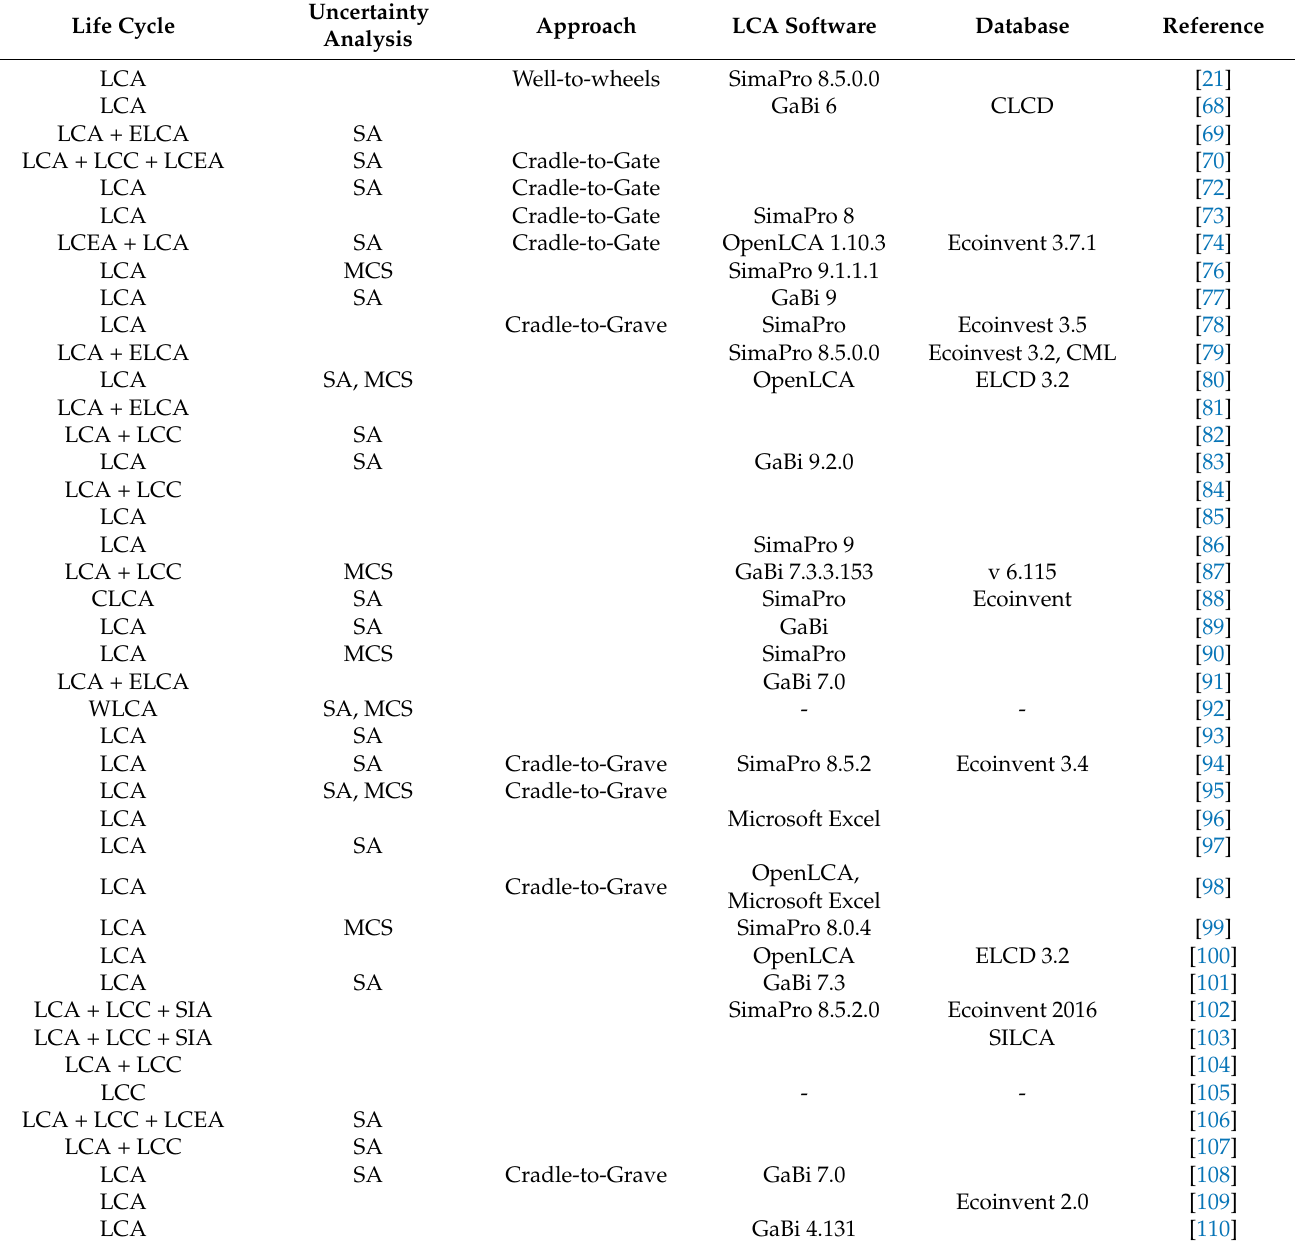
Table 6. Overview of life cycle methods, approaches, used software, and databases in 42